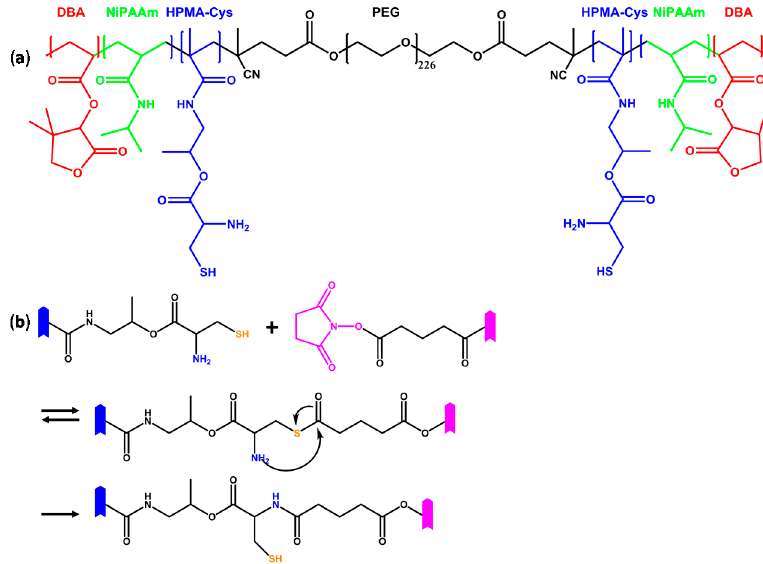
Figure 5. ( a ) Thermoresponsive macromer that can be chemically cross-linked by oxo-ester mediated native chemical ligation composed of a poly(ethylene glycol) (PEG) macroinitiator, thermosensitive NiPAAm (green), degradable dimethyl- γ -butyrolactone acrylate (DBA, red) and N -(2- hydroxypropyl)-methacrylamide-cysteine (HPMA-Cys, blue) bearing thiol groups [74]; ( b ) Mechanism of oxo-ester mediated native chemical ligation between thiol group (orange) of the Figure 1. Selected functional groups used for chemical cross-linking of macromers by cross- macromer and an NHS-ester-functionalized cross-linker (magenta) [77]. The symbol polymerization. The symbol represents an oligomer segment that contains a functional represents an oligomer segment that contains a functional group (blue, magenta). The initial reaction is a reversible transthioesterification step which is chemoselective and regioselective. The thioester intermediate rearranges by an intramolecular S , N -acyl shift that results in the formation of a stable native amide. Note that the resulting network provides fee thiol moieties for additional functionalization reactions.